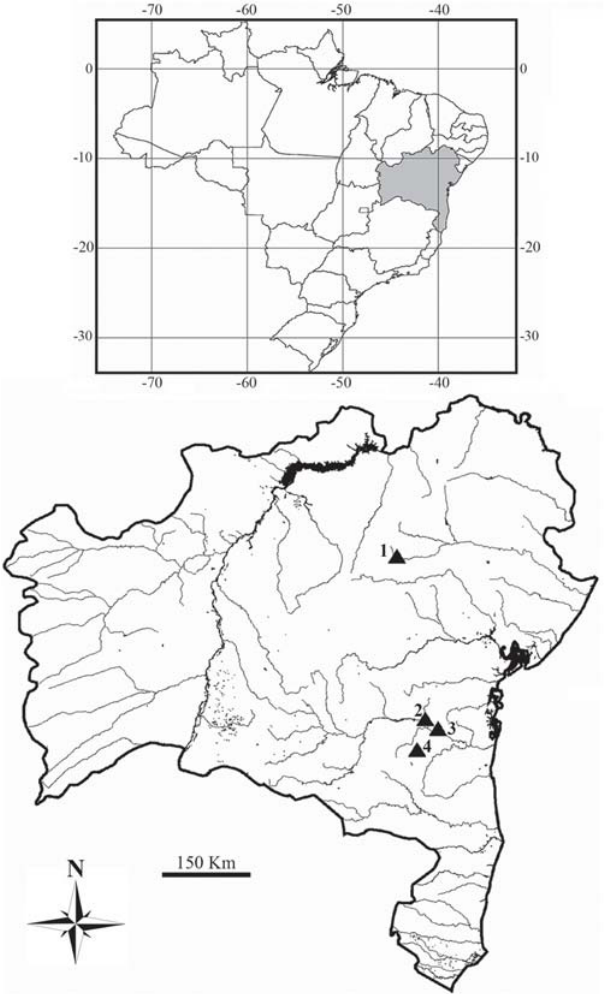
Fig. 1. Contas and Itapicuru River basins (BA). The triangles indicate the collection sites in the following rivers: 1